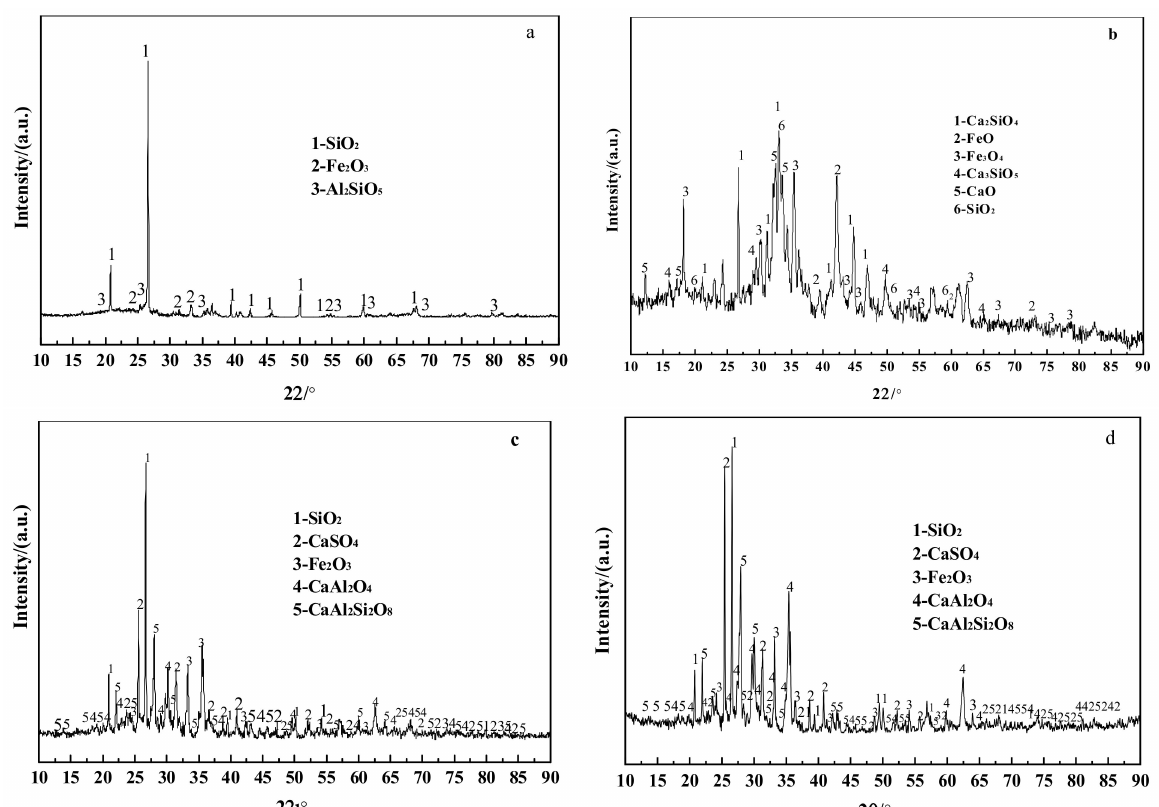
Figure 4. XRD patterns of ash and steel slag. ( a ) F 1 ; ( b ) Steel slag; ( c ) F 2 ; ( d ) F 3